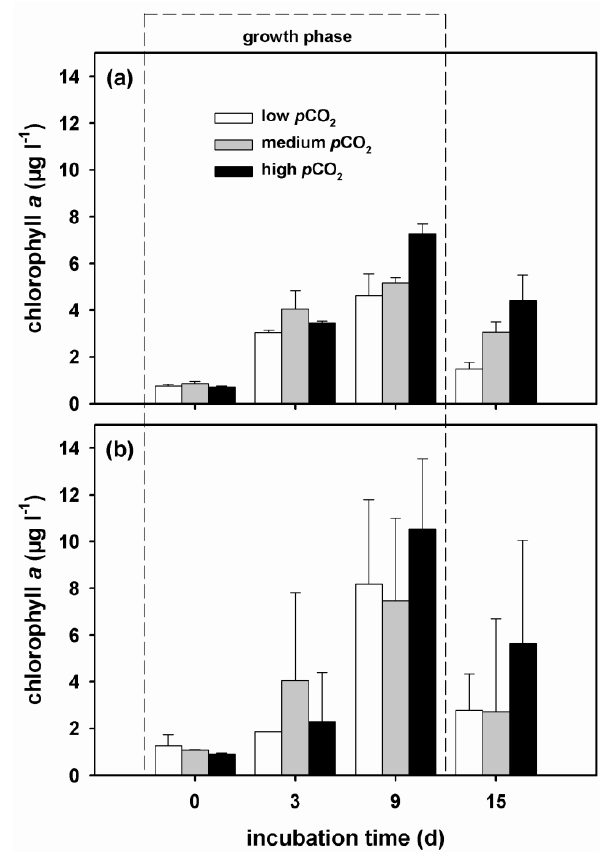
Fig. 2. Comparison of the Chlorophyll a distribution over incuba- Fig. 2: Comparison of the Chlorophyll a distribution over incubation time and for the different 982 tion time and for the different p CO 2 treatments (low = white bars, medium = grey bars, high = black bars) in the 10l batch bottles p CO treatments (low = white bars, medium = grey bars, high = black bars) in the 10 l batch 983 2 (a) (as shown by Wannicke et al., 2012; Endres et al., 2013), and in the 0.5l [ 33 P] bottles (b) (mean values and the respective standard bottles (a) (as shown by Wannicke et al., 2012; Endres et al., 2013), and in the 0.5 l [ 33 P]- 984 deviation of 3 bottles (b) (mean values and the respective standard deviation of 3 replicates). 985